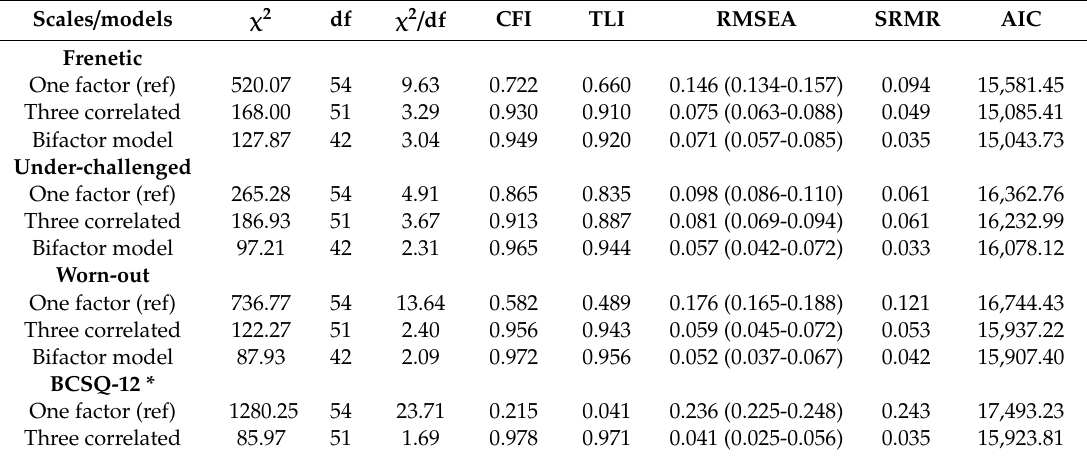
Table 2. Fix indices for the frenetic, under-challenged, and worn-out BCSQ-36 and BCSQ-12 scales. Scales / models